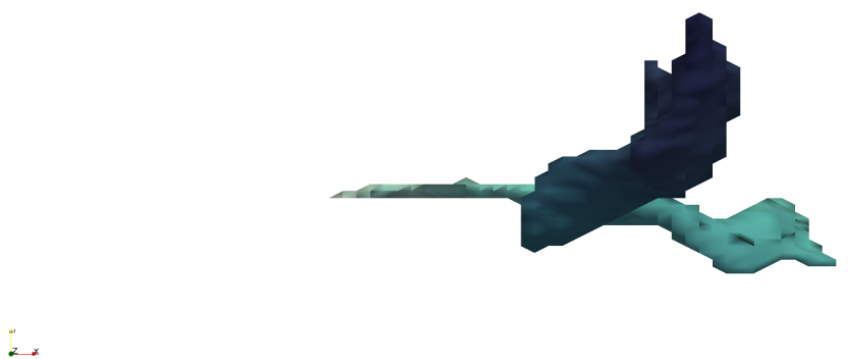
Figure 1. Representation of a sweep-ejection pair from a single DNS time